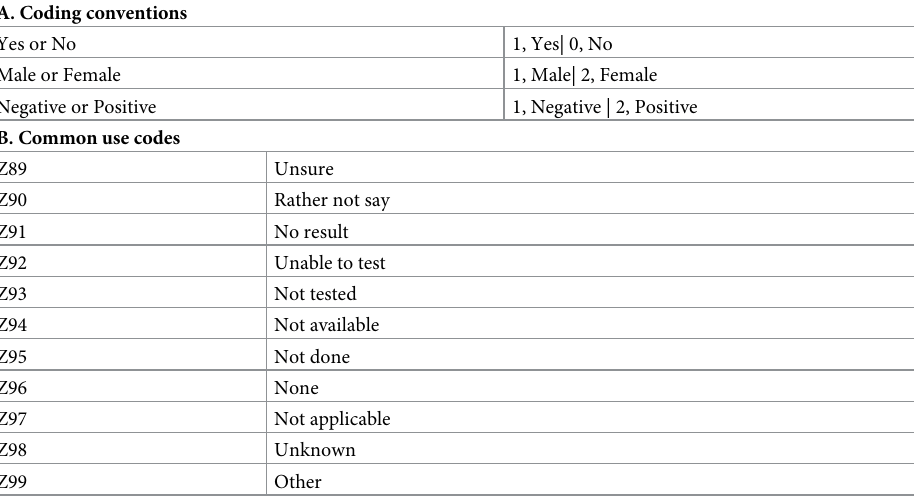
Table 2. A. Example of coding conventions, and B. List of commonly used